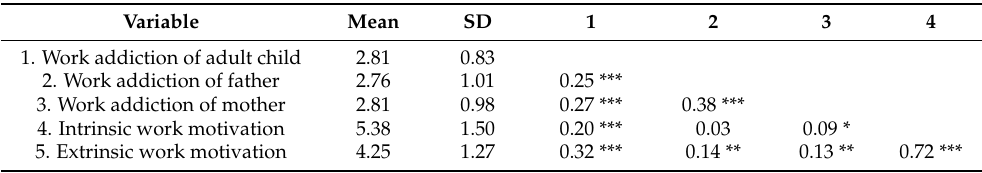
Table 3. Correlations, means and standard deviations of the study